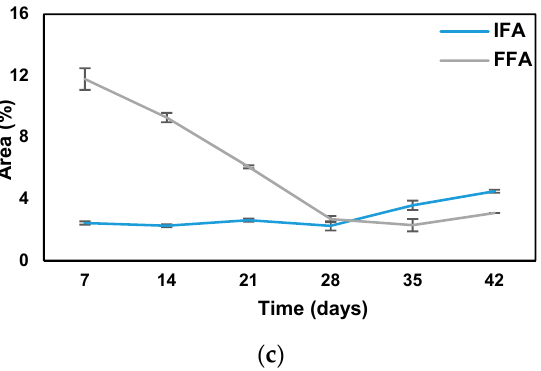
Figure 6. Content (area percentage, mean value ± SD) of octanal ( a ), trans -2-octenal ( b ), and trans , trans -2,4-heptadienal ( c ) in FFA and IFA series during heating.